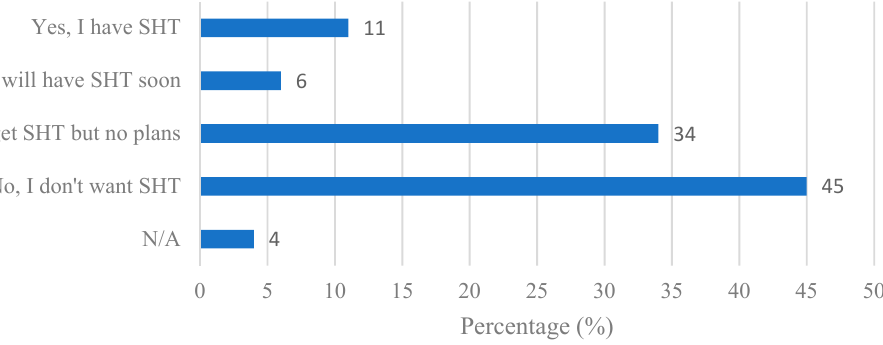
Figure 1. Age 50 and older who have SHT in UAE.